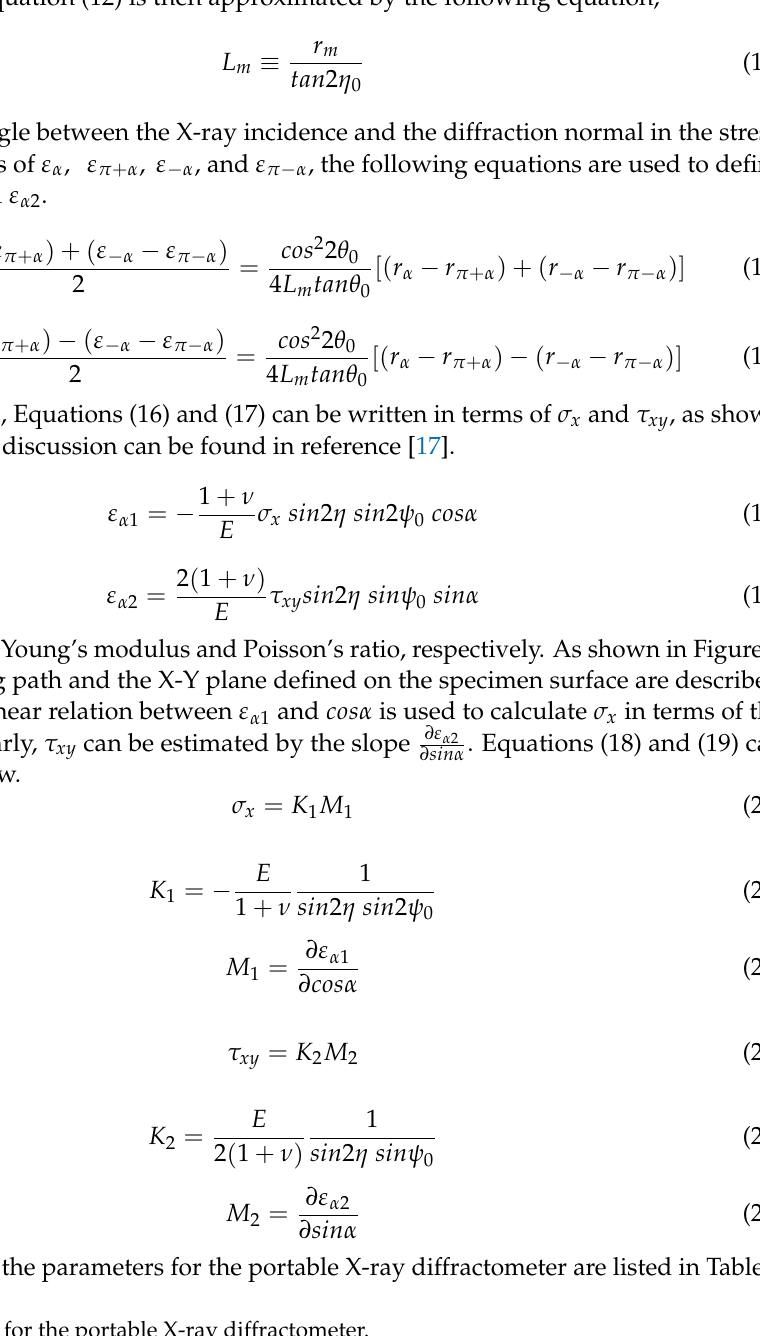
Table 2. Parameters for the portable X-ray diffractometer. Item Unit Value Measuring diameter mm 5 X-ray irradiation time (setup) sec 15 X-ray irradiation time (meas.) sec 15 X-ray irradiation time (max.) sec 15 X-ray tube current mA 1.50 X-ray tube voltage kV